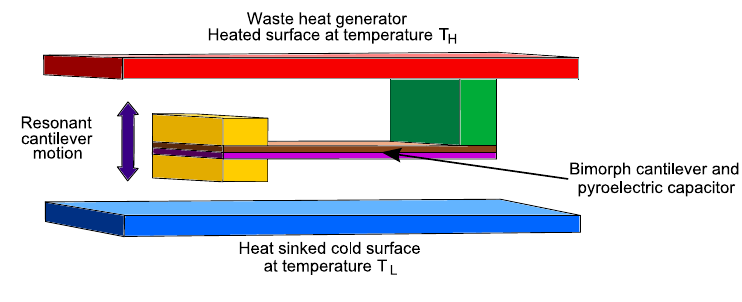
Figure 13. Pyroelectric harvester.